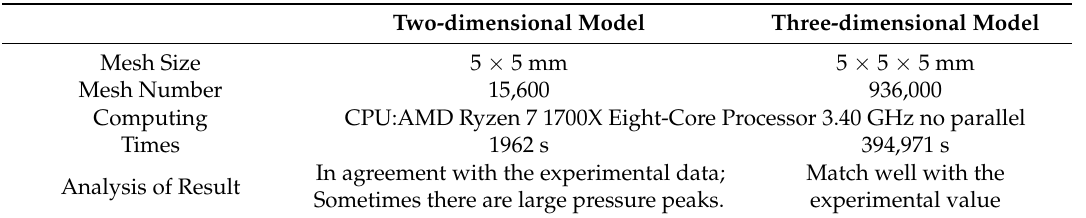
Table 1. The comparison of parameters between the 2D model and 3D model.